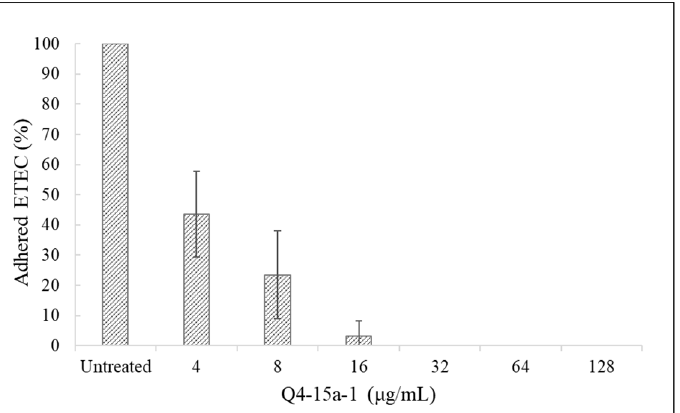
Figure 7. Inhibitory effect of Q4-15a-1 against the adherence of MDR ETEC to IPEC-1 cells.